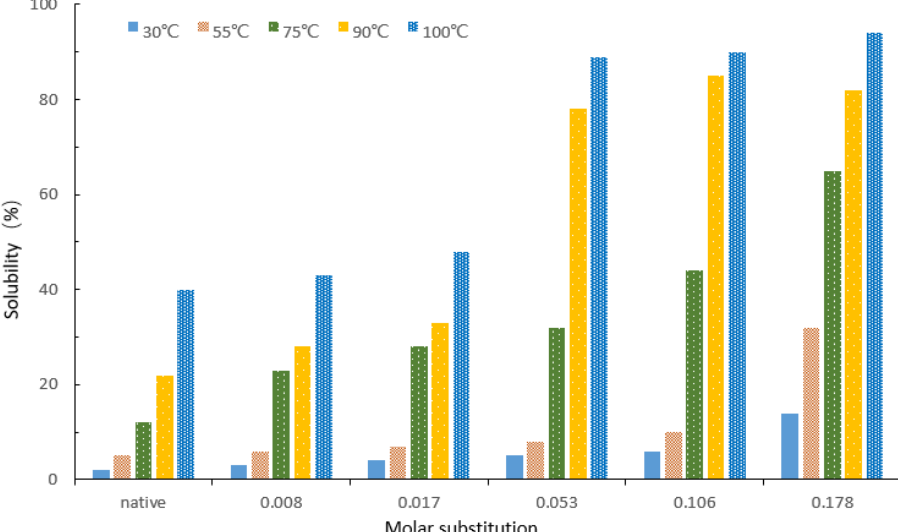
Figure 4. Solubility of native starch and γ -HPS at different temperatures and ratios of MS.